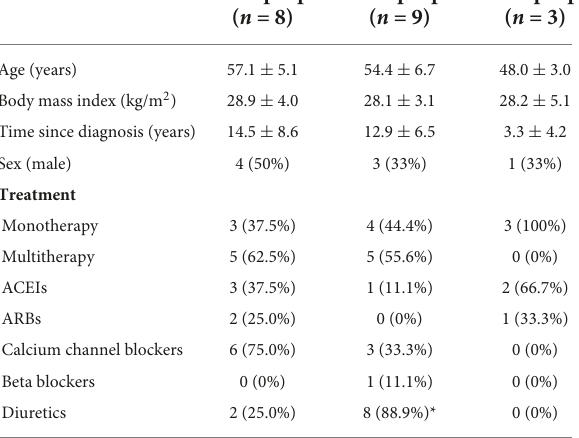
TABLE 2 Demographic and clinical characteristics of participants by